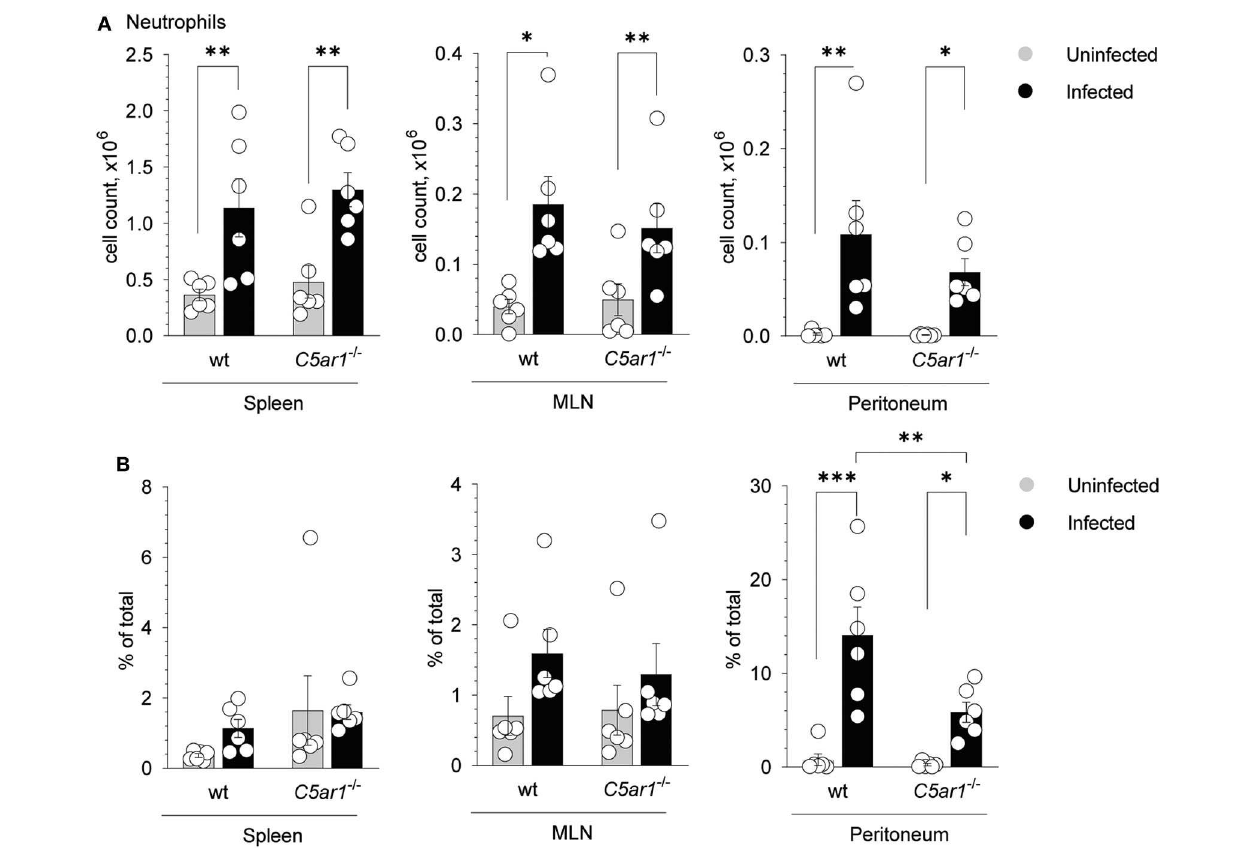
FIGURE 3 | Impact of C5aR1 activation on neutrophil recruitment into the spleen, mesenteric lymph nodes and the peritoneum. (A,B) Number (A) or frequency (B) of neutrophils in the spleen (left panel), mesenteric lymph nodes (MNL; middle panel) and peritoneum (right panel) of uninfected and T. gondii -infected wt and C5ar1 − / − mice. Values shown are the mean ± SEM; n = 6/group. Differences between groups were determined by ANOVA and Sidak’s post-hoc test, * p < 0.05, ** p < 0.01, *** p <